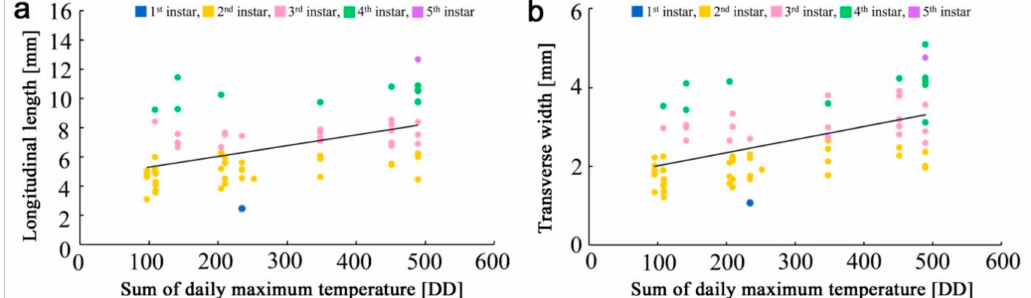
Figure 4. Scatter plots showing the relationships between larval body size and the sum of the daily maximum temperature. Colors of dots indicate larval instars. ( a ) Scatter plot for longitudinal length (larval length). A linear regression line is shown; ( b ) Scatter plot for transverse width (larval width). A linear regression line is shown.